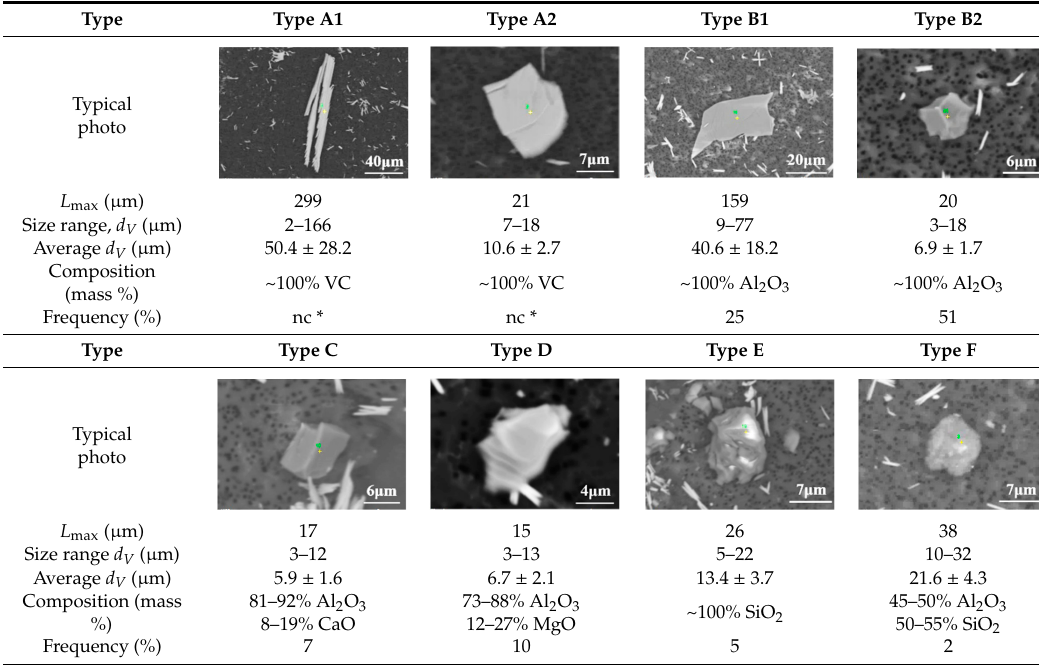
Table 2. Classification of inclusions found in FeV alloys.